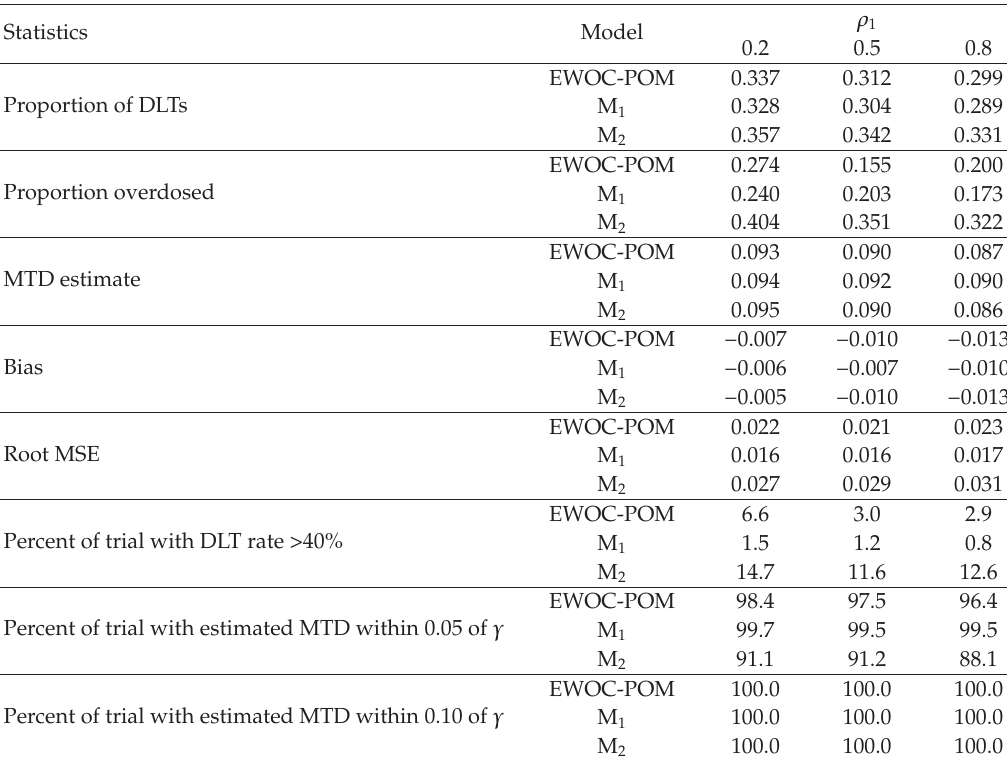
Table 2: Summary statistics for trial safety and e ffi ciency under model misspecification when the true MTD γ (cid:7) 0 . 1. Rows 2–6 give the summary statistics based on all patients from all 1000